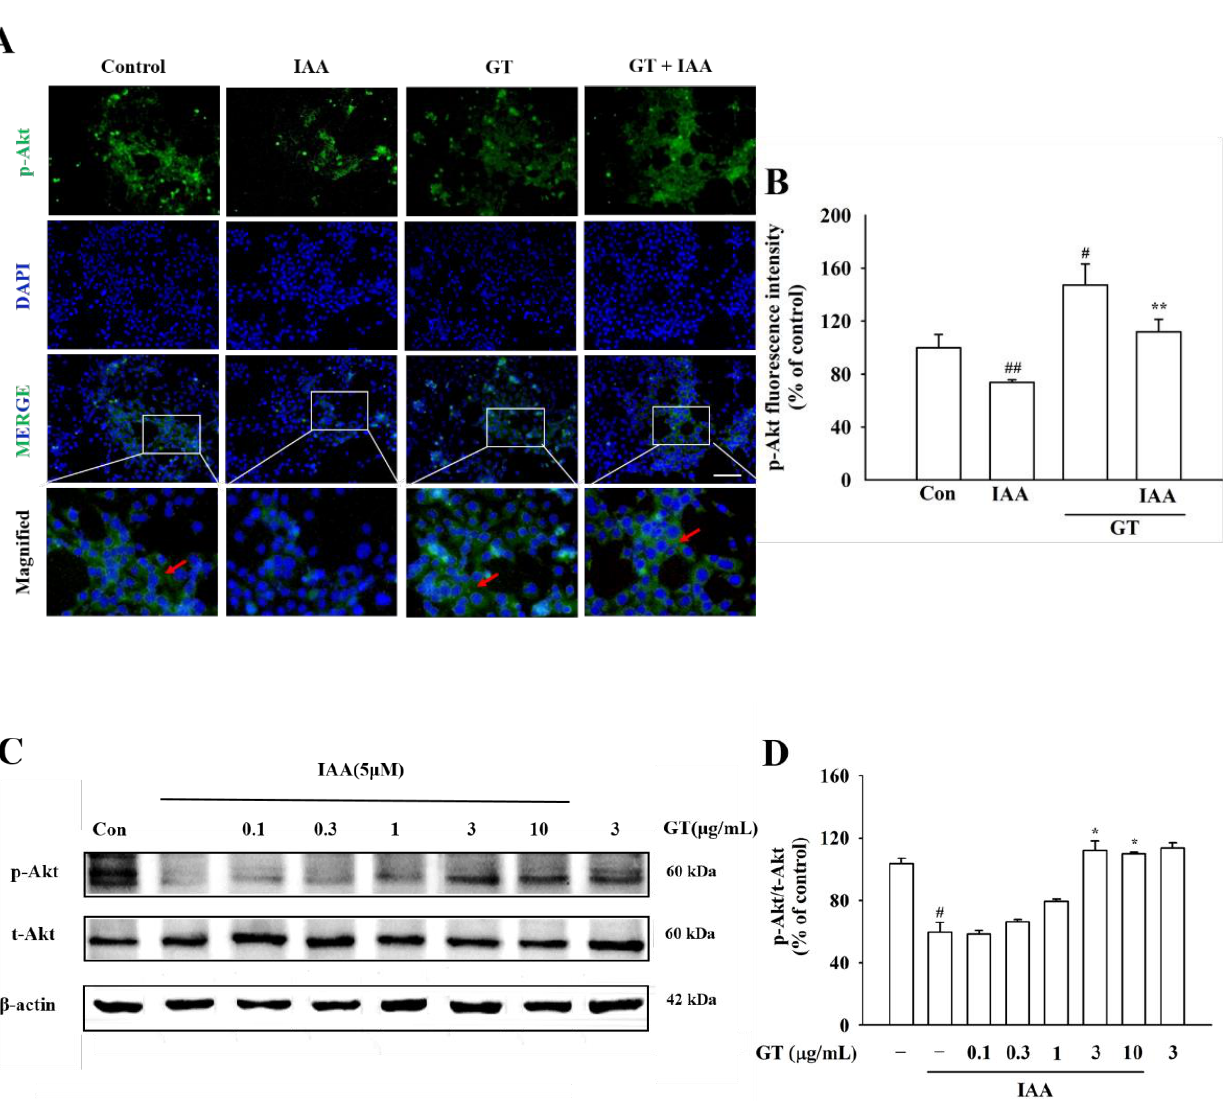
Figure 6. Effect of gintonin on Akt phosphorylation in the presence of IAA in HT22 cells. ( A ) Representative microscopy images of Akt phosphorylation. The phosphorylation of Akt was detected using immunochemistry staining. HT22 cells were treated with IAA (5 μM, 2 h), followed by exposure to gintonin (3 μg/mL, 24 h). Phosphorylated TrkB is dyed green, and nuclei are dyed blue using DAPI. Microscopic images were captured at the same magnification, scale bar = 100 μm. ( B ) Quantitative analysis of the images obtained from fluorescence microscopy. ( C ) The expression of p-Akt and t-Akt proteins was detected by Western blot analysis using β-actin as a loading control. ( D ) p-Akt/t-Akt ratio at each dose. The data are represented as the mean ± SEM ( n = 4). # p < 0.05 and ## p < 0.01 compared to control group; * p < 0.05 and ** p < 0.01 compared to the IAA-treated group.